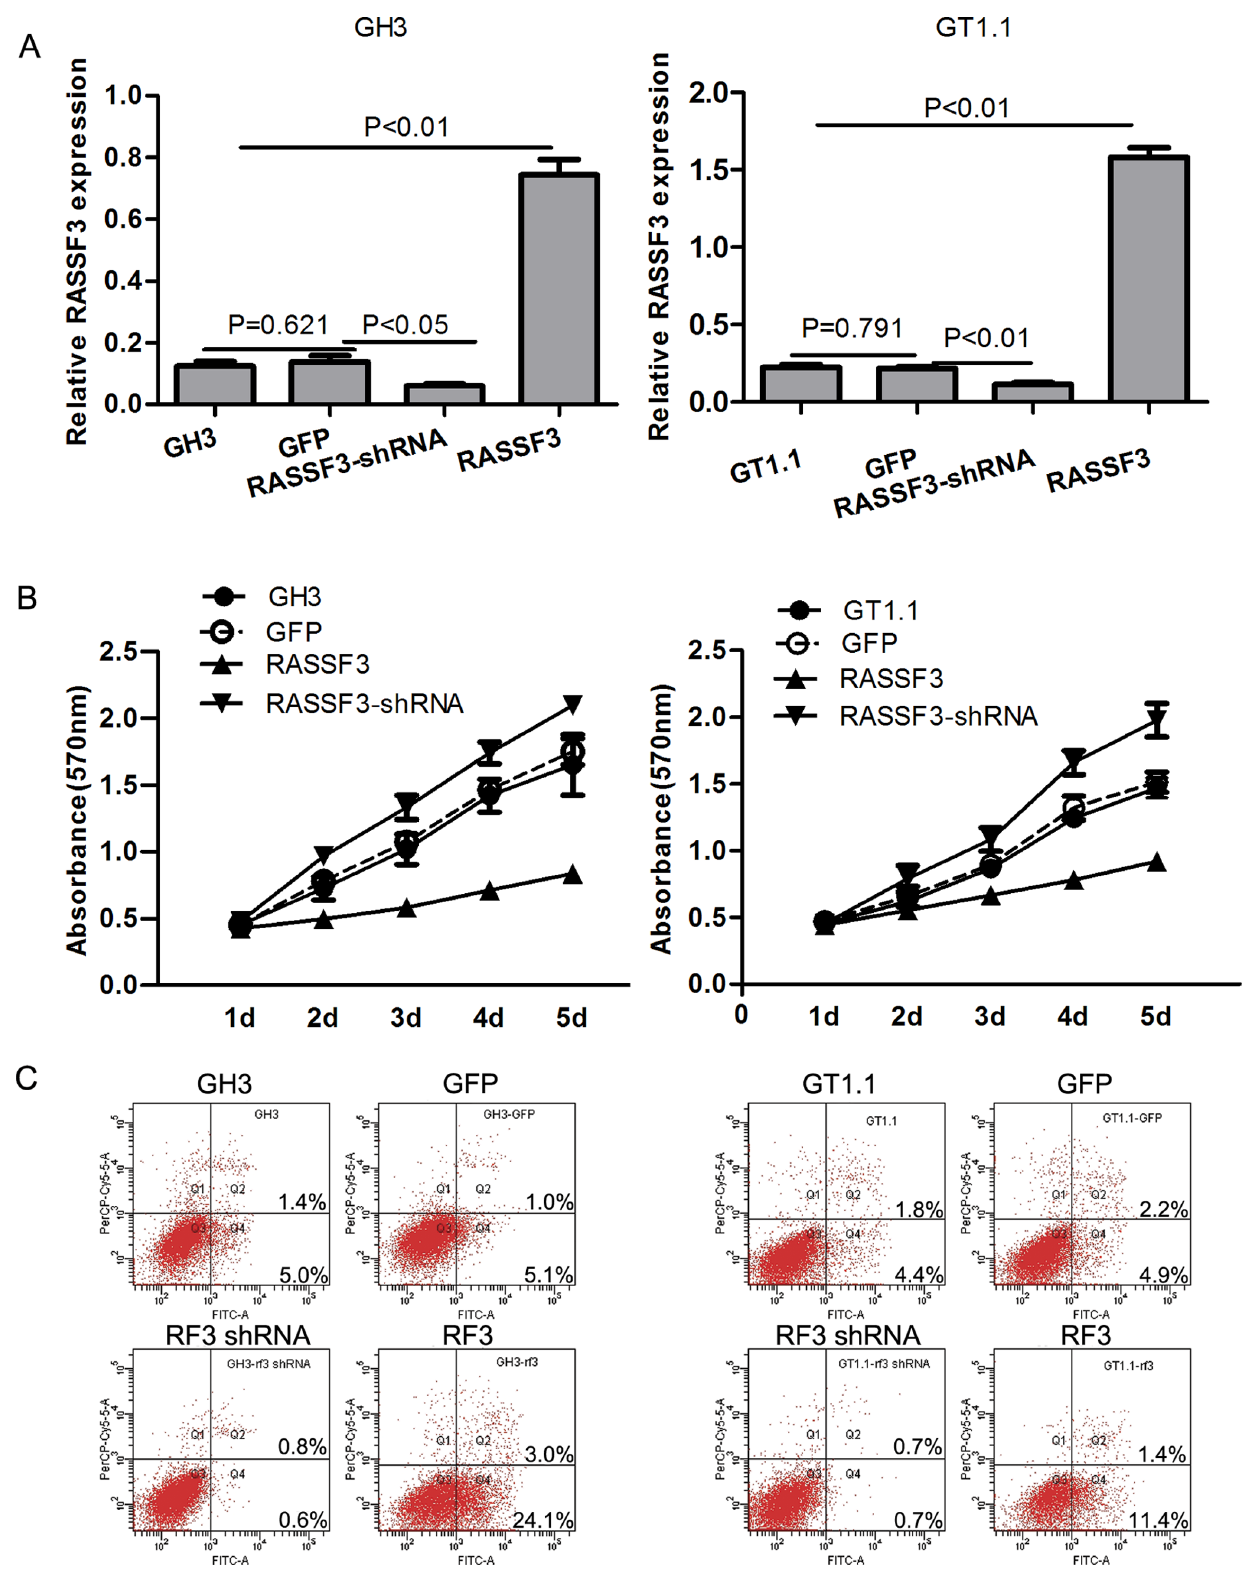
Figure 4. Effects of RASSF3 transfection on somatotroph cell proliferation and apoptosis. (A) Compared with cells stably transfected with Lenti-GFP, qRT-PCR analysis demonstrated that RASSF3 mRNA was significantly improved in somatotroph cells stably transfected with Lenti-RASSF3, and decreased in somatotroph cells stably transfected with Lenti-RASSF3 shRNA. (B) Effect of RASSF3 overexpression and suppression on GH3 cell proliferation was measured by MTT assay. Absorbance was read at 570 nm and the average value was calculated from 3 wells. (P , 0.05 at 48, 72, 96,